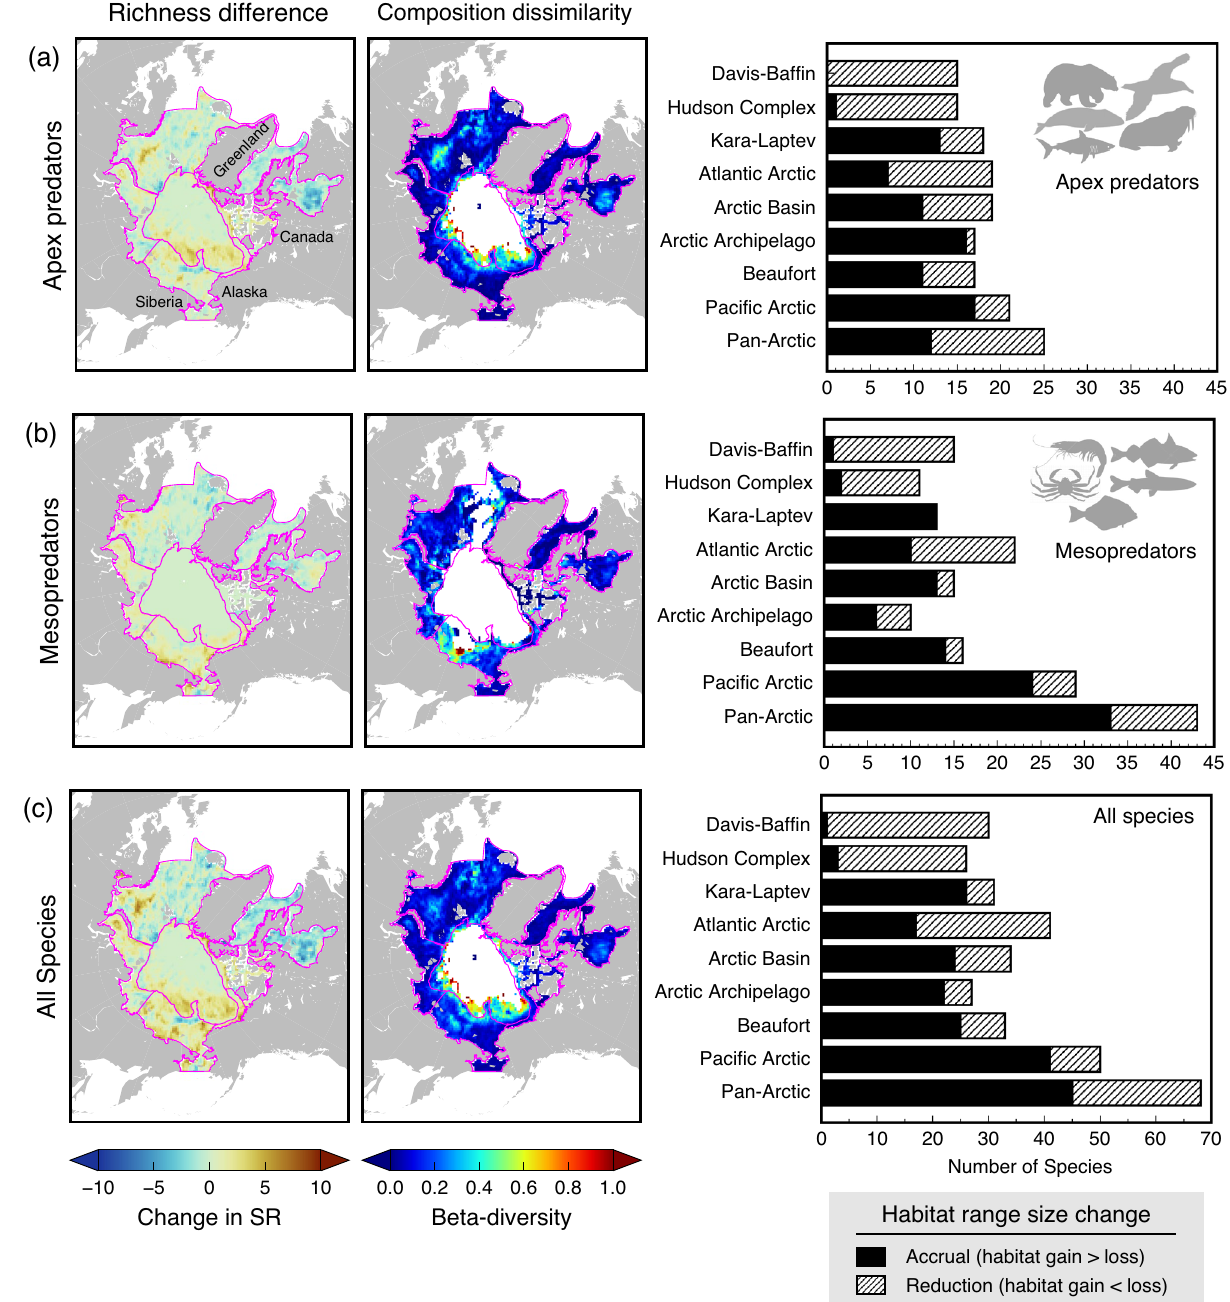
Figure 4. Difference in species richness (low–high sea ice; left panel) and species community composition (middle panels) under contrasting sea ice for ( a ) apex predators, ( b ) mesopredators, and ( c ) all species from 2000 to 2019. Right panels show the number of species exhibiting habitat range size changes between high and low sea ice periods for each Arctic marine area. The maps were created using GMT 6.3.0 (https:// docs. gener ic- mappi ng- tools. org/6. 3/ gmt.